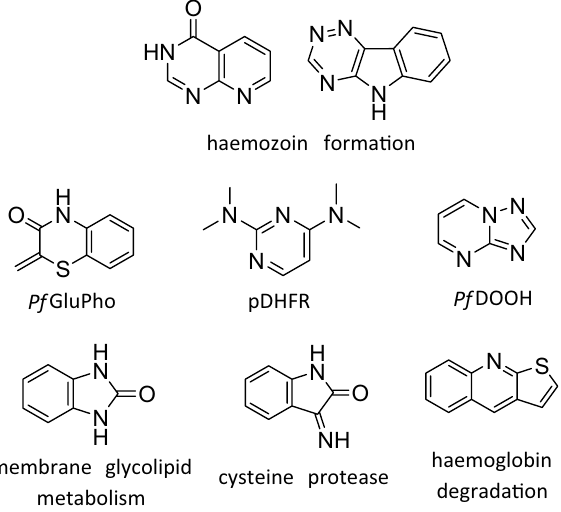
Figure 2. Scaffolds predicted bioactive by the SVM and/or Bayesian classification models that are not present in the training set but have documented activity against Plasmodium spp. Their proposed targets are given